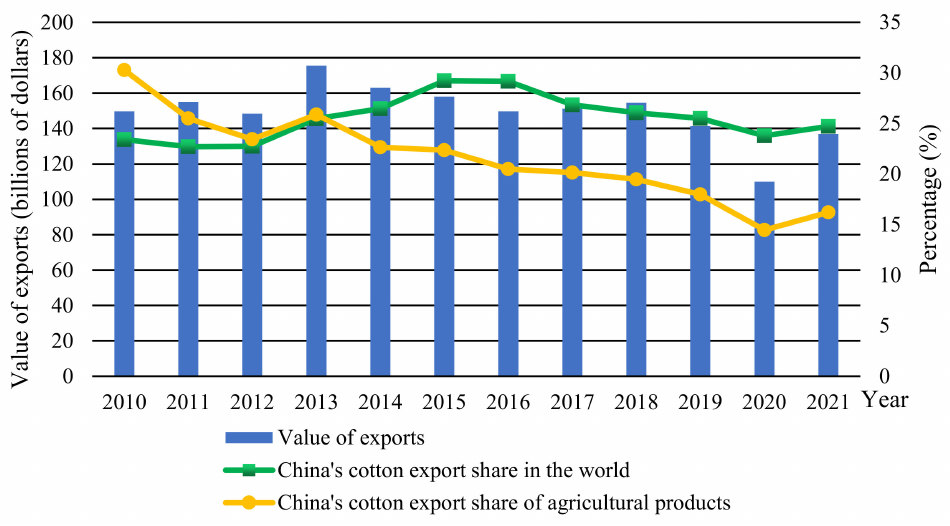
Figure 2. China’s cotton exports from 2010 to